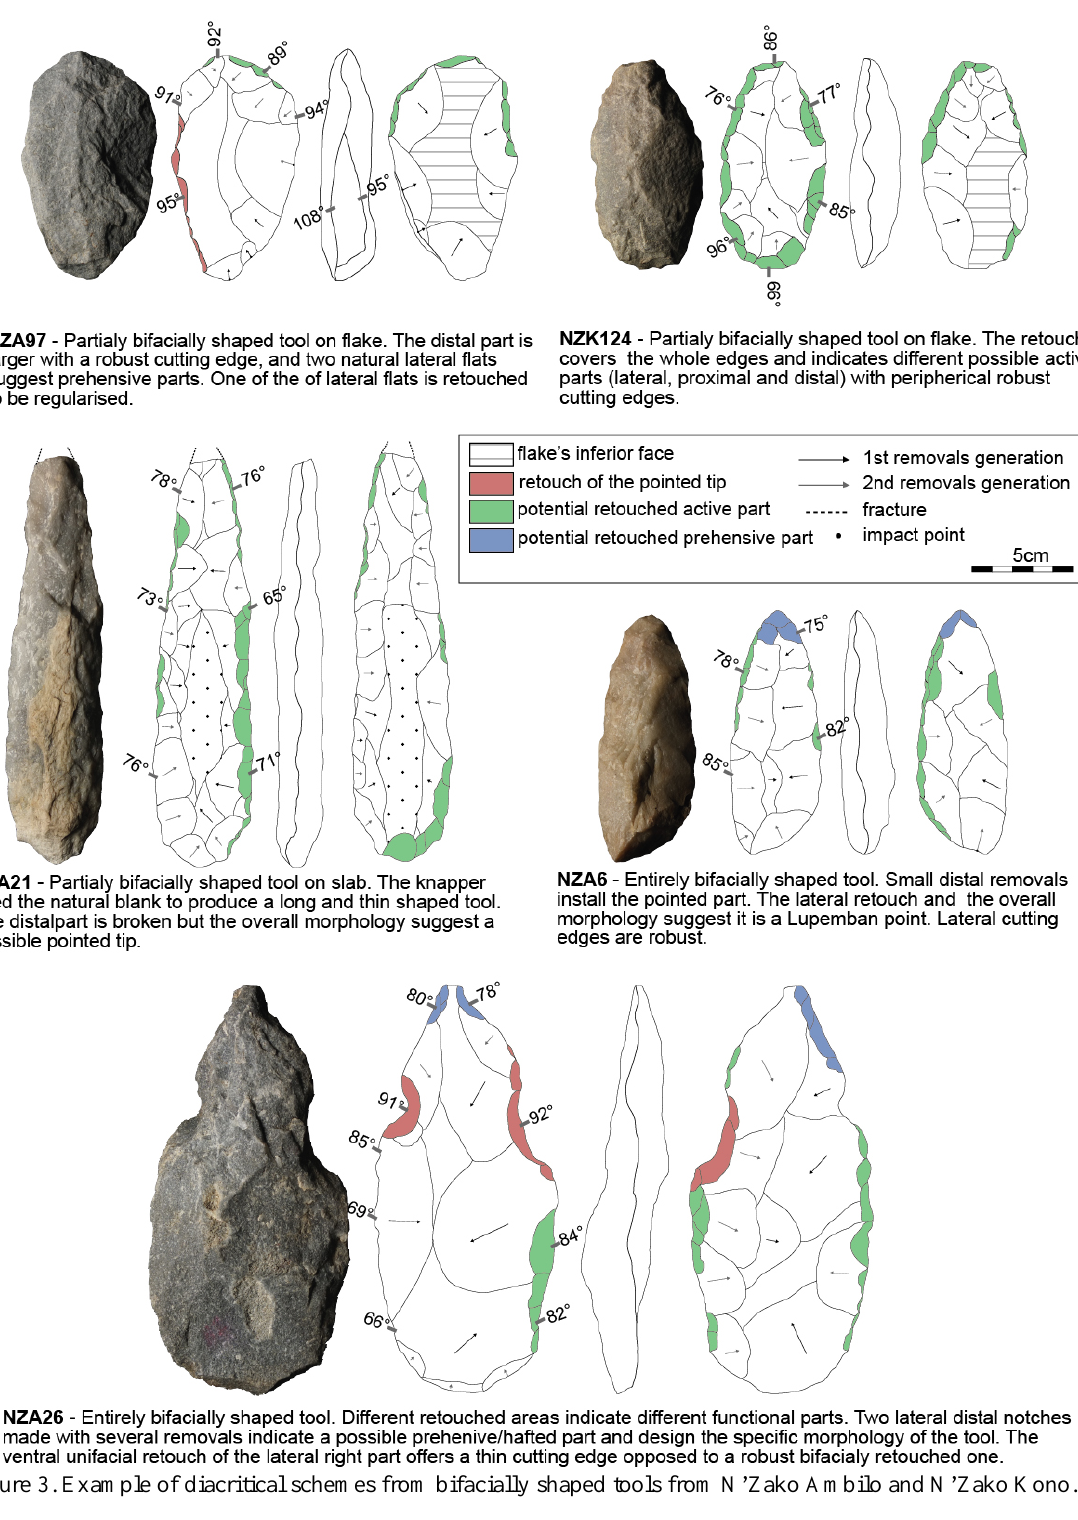
Figure 3. Example of diacritical schemes from bifacially shaped tools from N’Zako Ambilo and N’Zako